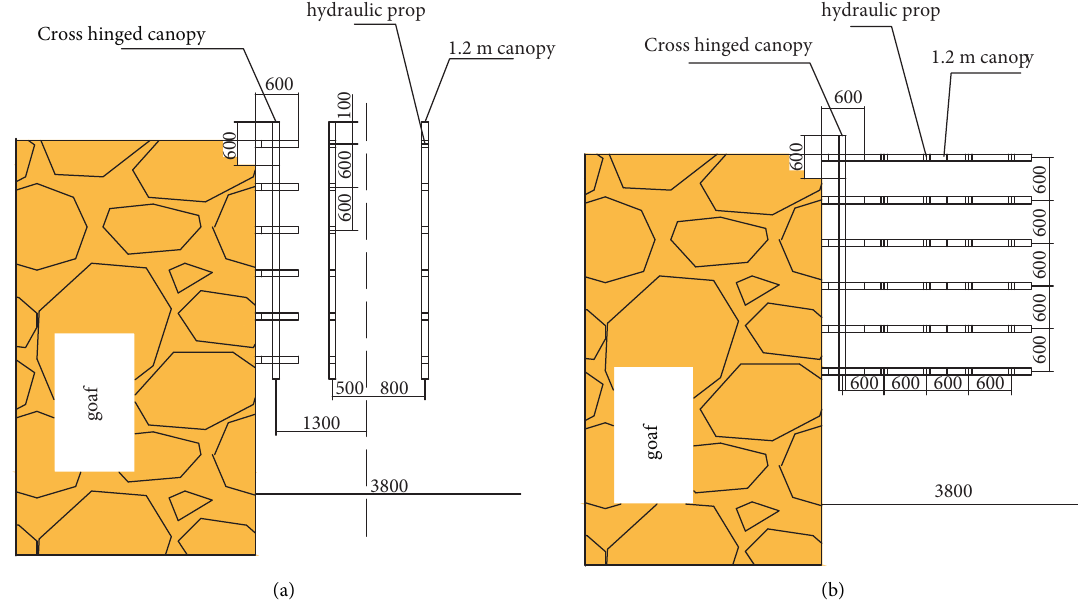
Figure 9: Support method of the crossheading along the gob-side entry retaining. (a) Normal section. (b) Crushed roof section.